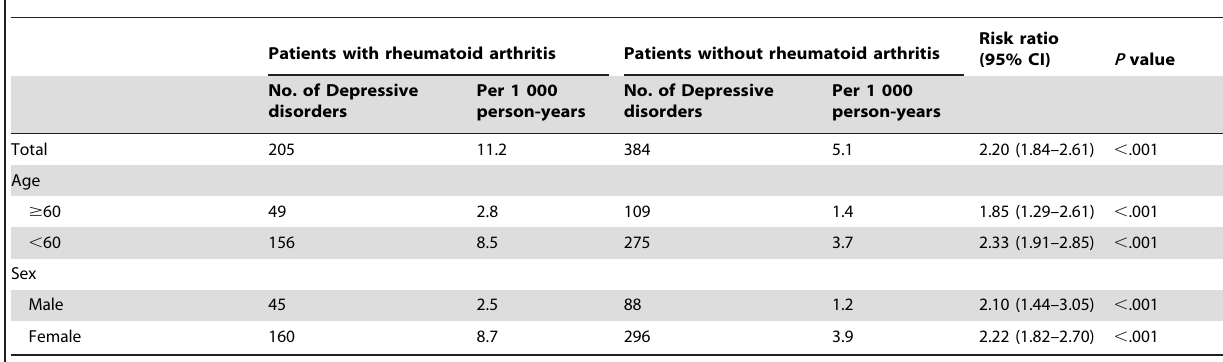
Table 2. Incidence of Depressive Disorders in Patients with and without Rheumatoid Arthritis.